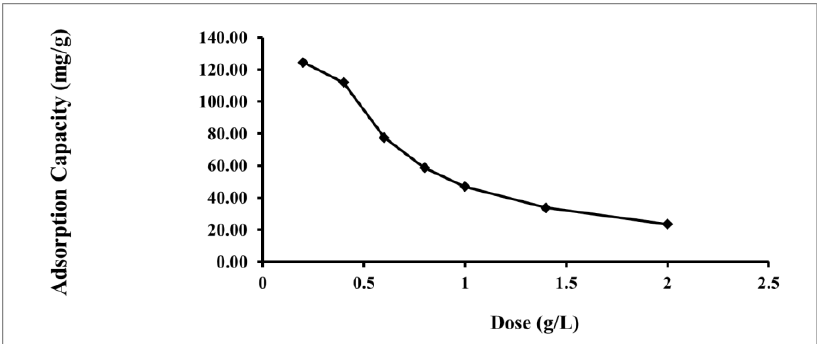
Figure 6. Effect of adsorbent dose on Hg(II) adsorption; Hg(II) solution dose of 50 mg/L at pH 4.